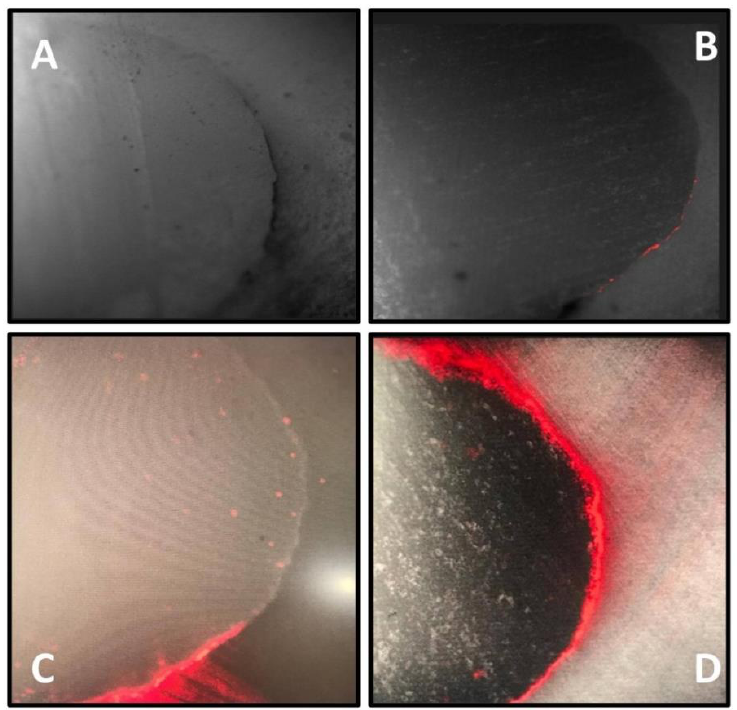
Figure 5. ( A – D ) Images of confocal laser microscopy showing scoring criteria with ( A ) Score 0; ( B ) Score 1; ( C ) Score 2; ( D ) Score 3.